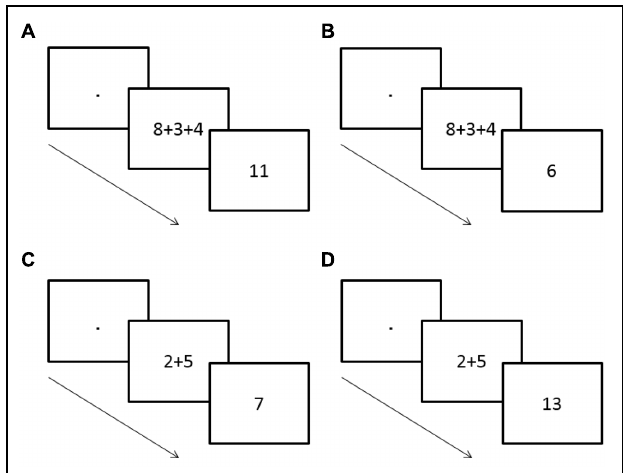
FIGURE 4 | Schematic representations of the experimental paradigm along with the various conditions are displayed. An addition task of two or three addends is presented for 150 ms followed by a target number. The task is to determine whether the target number is odd or even, while ignoring the arithmetic addition problem. (A) The intermediate sum of two addends in a prime of a three addend problem is congruent with the target. Correct response: “odd” (B) The intermediate sum of two addends in a prime of a three addend problem is incongruent with the target. Correct response: “even.” (C) The sum of two addends in a prime of a two addend problem is congruent with the target. Correct response: “odd.” (D) The sum of two addends in a prime of a two addend problem is incongruent with the target. Correct response: